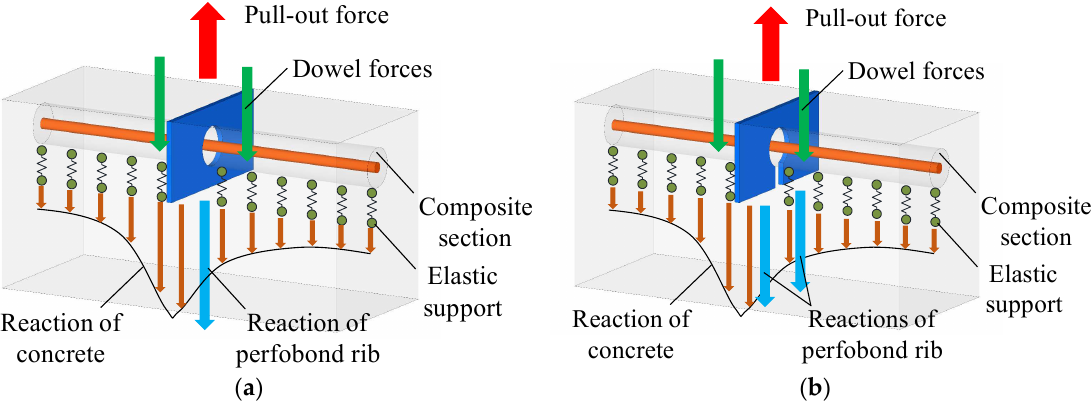
Figure 6. Pull-out mechanism. ( a ) Conventional perfobond shear connector; ( b ) notched perfobond shear connector.